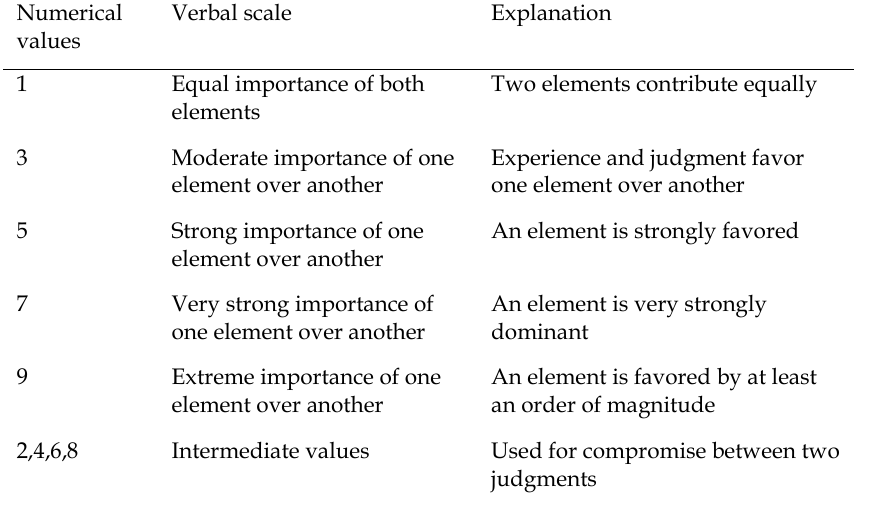
Judgment scale of relative importance for pairwise comparison (Saaty,